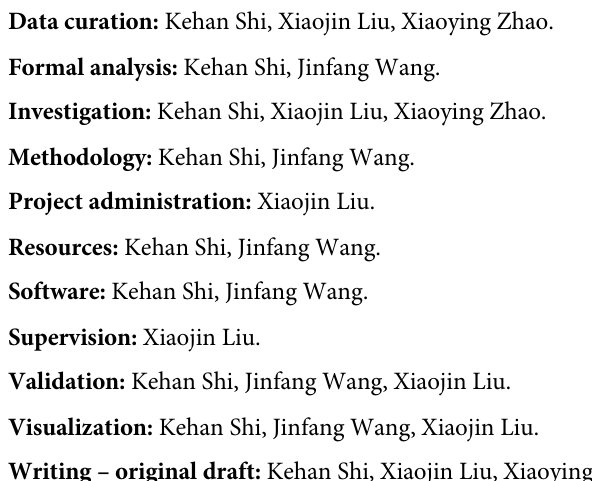
S1 Table. Abbreviation comparison